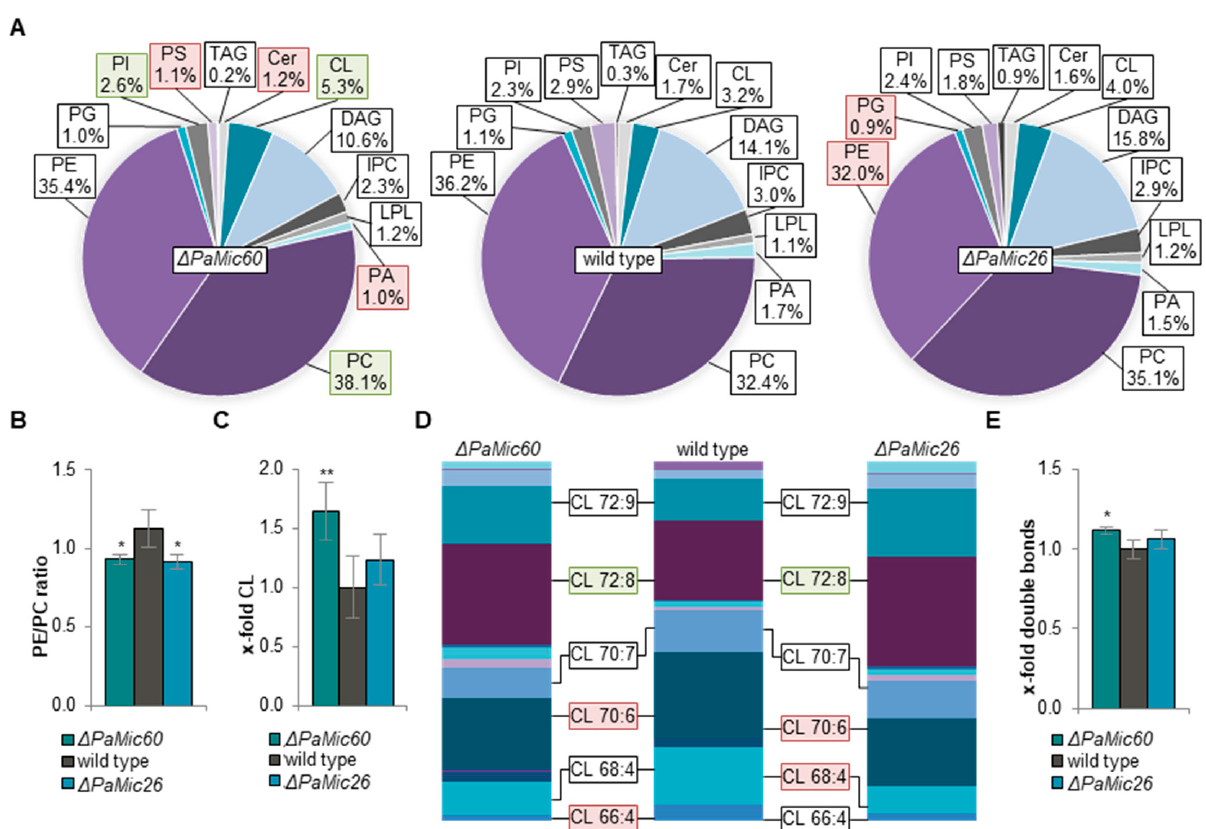
Figure 2. Ablation of MICOS subunits alters mitochondrial phospholipid composition. ( A ) Lipid profile of mitochondrial protein extracts of P. anserina wild type, Δ PaMic60 and Δ PaMic26 . Significant differences to the wild type are marked by green (increase) or red (decrease) boxes, respectively. Exact values are shown in Supplementary Materials (Table S1). TAG: triacylglycerol; Cer: ceramide; CL: cardiolipin; DAG: diacylglycerol; IPC: inositol phosphorylceramide; LPL: lyso-phos- pholipids; PA: phosphatidic acid; PC: phosphatidylcholine; PE: phosphatidylethanolamine; PG: phosphatidylglycerol; PI: phosphatidylinositol; PS: phosphatidylserine. ( B ) PE/PC ratio of wild type, Δ PaMic60 , and Δ PaMic26 . ( C ) Comparative analysis of CL from ( A ). Total amount of CL in wild-type cultures was set to 1. ( D ) Graphical illustration of different CL species in wild type, Δ PaMic60 , and Δ PaMic26 according to total length of all four acyl chains (66–74) and total degree of unsaturation (4–11). The most abundant CL species are represented. Significant differences to wild type of increased or reduced CL species are marked by green or red boxes, respectively. Exact values are shown in Supplementary Materials (Table S2). ( E ) Total double bonds across all lipids. Total